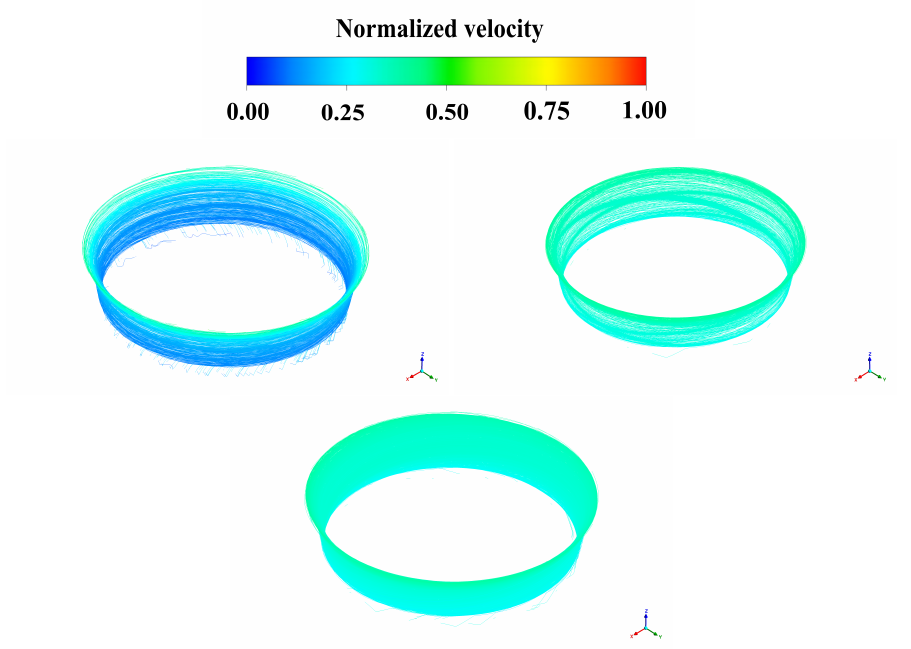
Figure 10. Velocity distributions of the bottom ring with the 0.5 mm ( top-left ), 1.5 mm ( top-right ), and 2.5 mm ( lower ) radial installation deviation